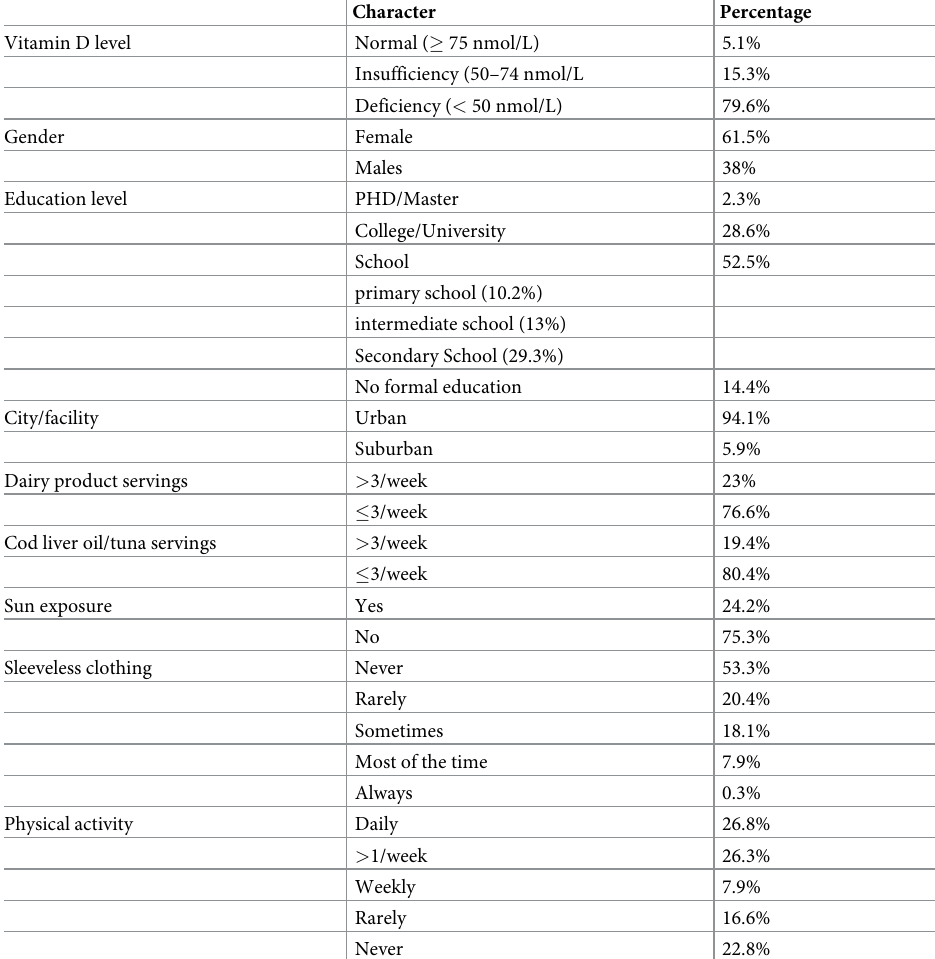
Table 1. Sociodemographic